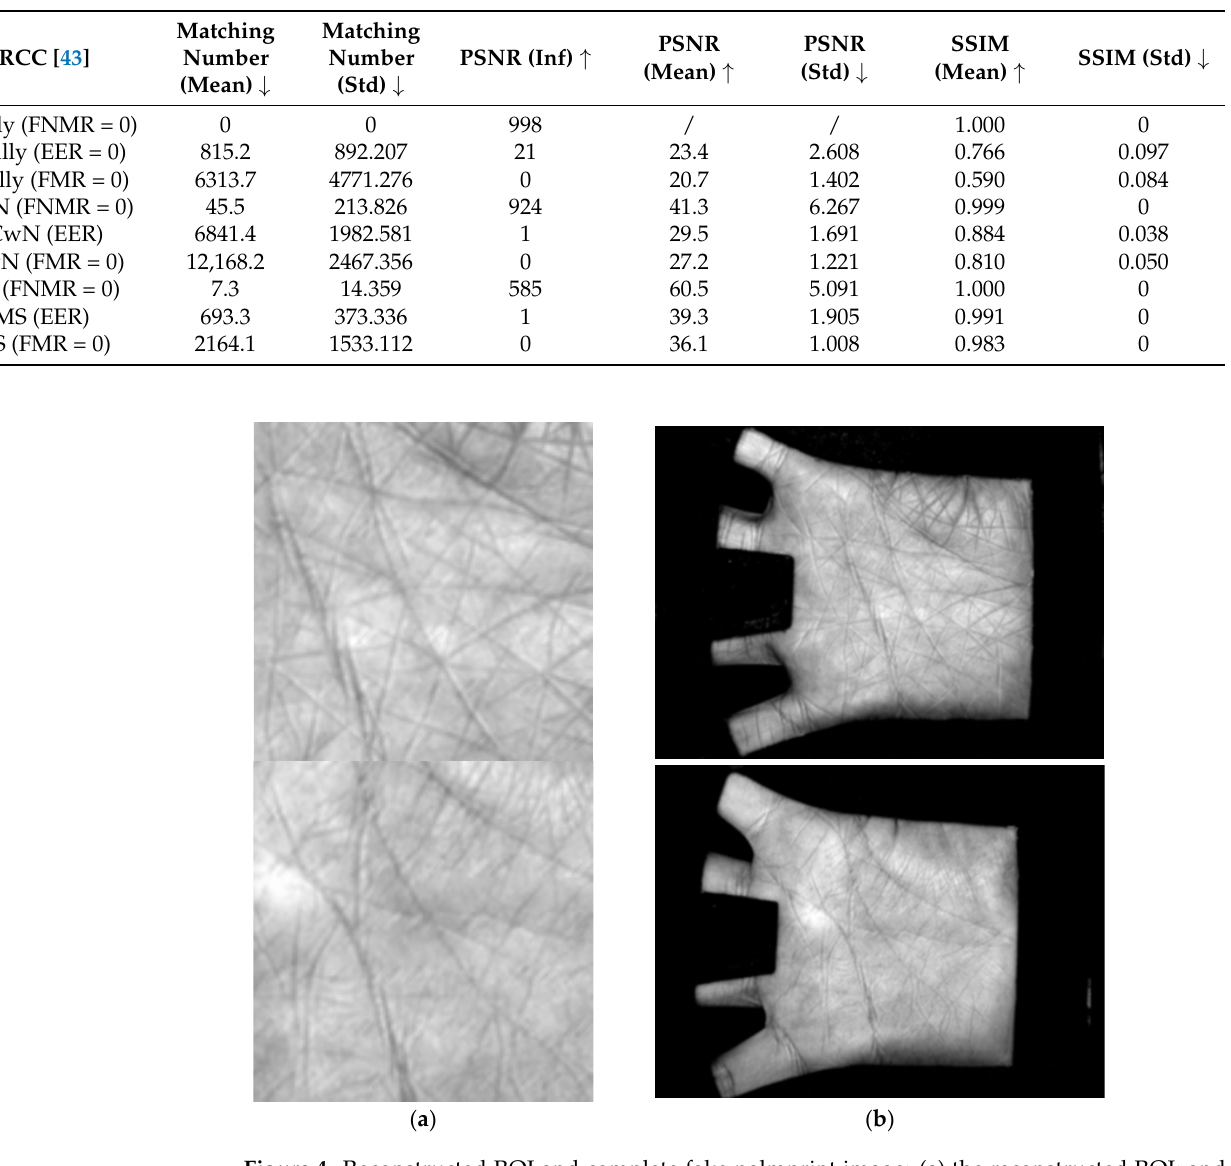
Figure 4. Reconstructed ROI and complete fake palmprint image: ( a ) the reconstructed ROI; and ( b ) the complete palmprint images with the embedding of the reconstructed